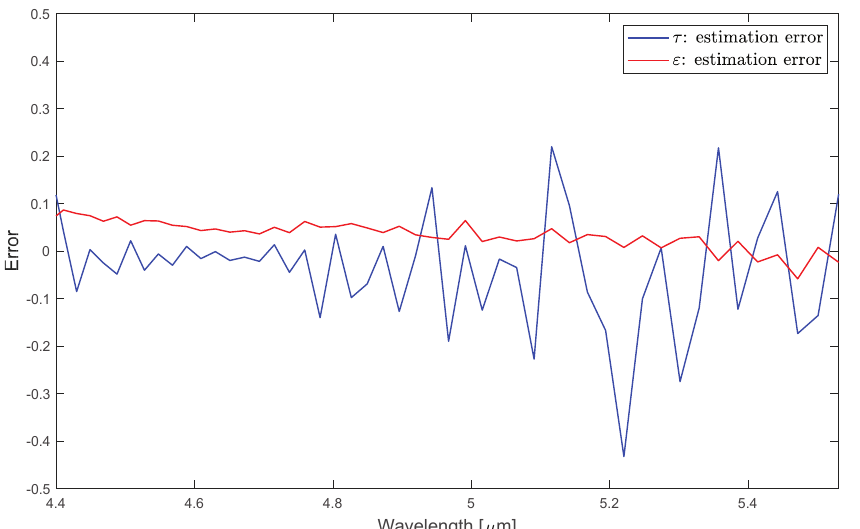
Figure 27. Asphalt region: Estimation error in spectral atmospheric transmittance and emissivity by the proposed AT 2 ES .